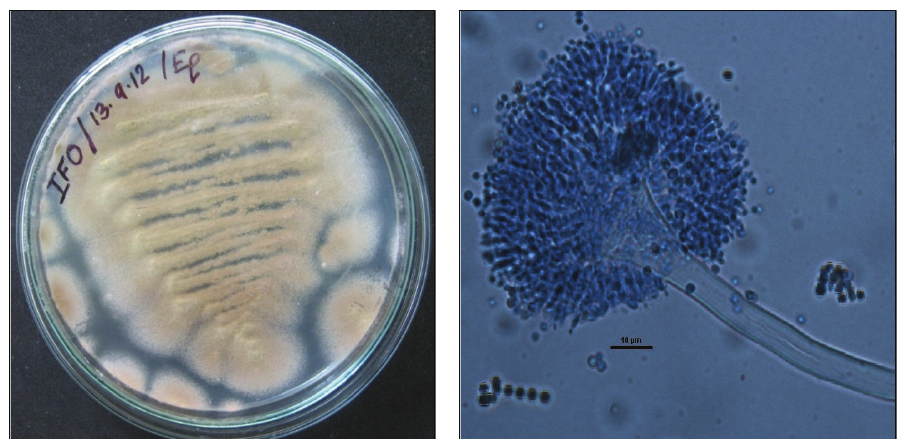
(b) Figure 1: Morphological features of the fungus: (a) growth on PDA plate, (b) phase contrast microscopic image.